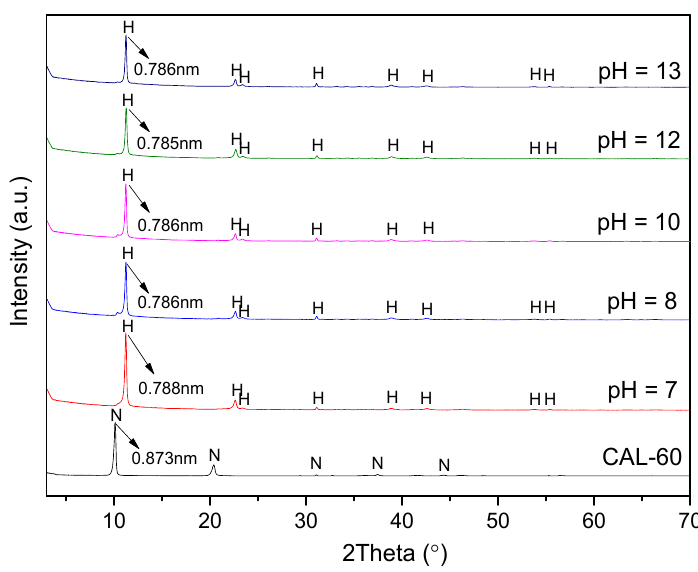
Figure 7. XRD patterns of CAL-60 and CAL-60 samples after adsorption of Cl − under different pH conditions (N refers for CaAl-NO 3 − type LDH; H refers for Hydrocalumite).